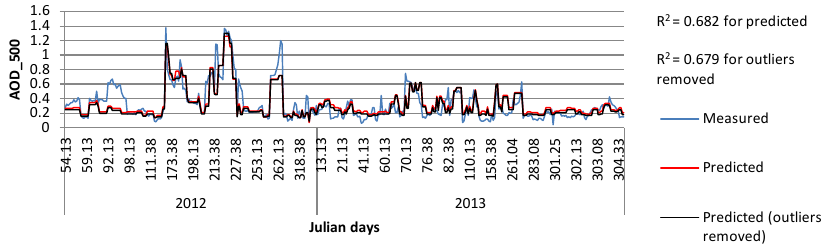
Figure 5. Predicted and measured AOD at 500nm for 2012 and 2013 for validation data set (subset 2, with 395 data points). The plot in black are predicted AOD values using (cid:2) a i (cid:3) obtained data set with potential outliers removed, whereas that in red is with data set without removing potential